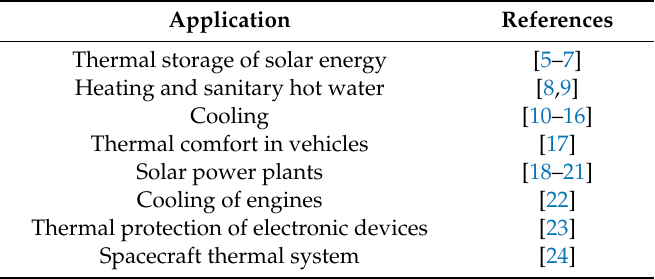
Table 1. Phase change material (PCM)